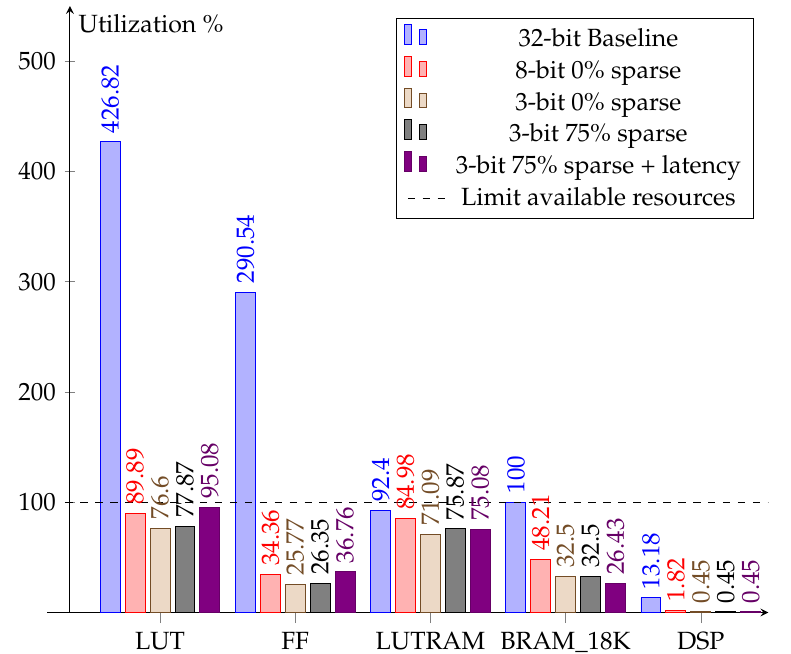
Figure 11. Vivado synthesis: Resource usage (% of available resources of the Zynq Z-7020 FPGA) for different model configurations, with maximal reuse factor for each layer and the latency-optimized solution with optimized reuse